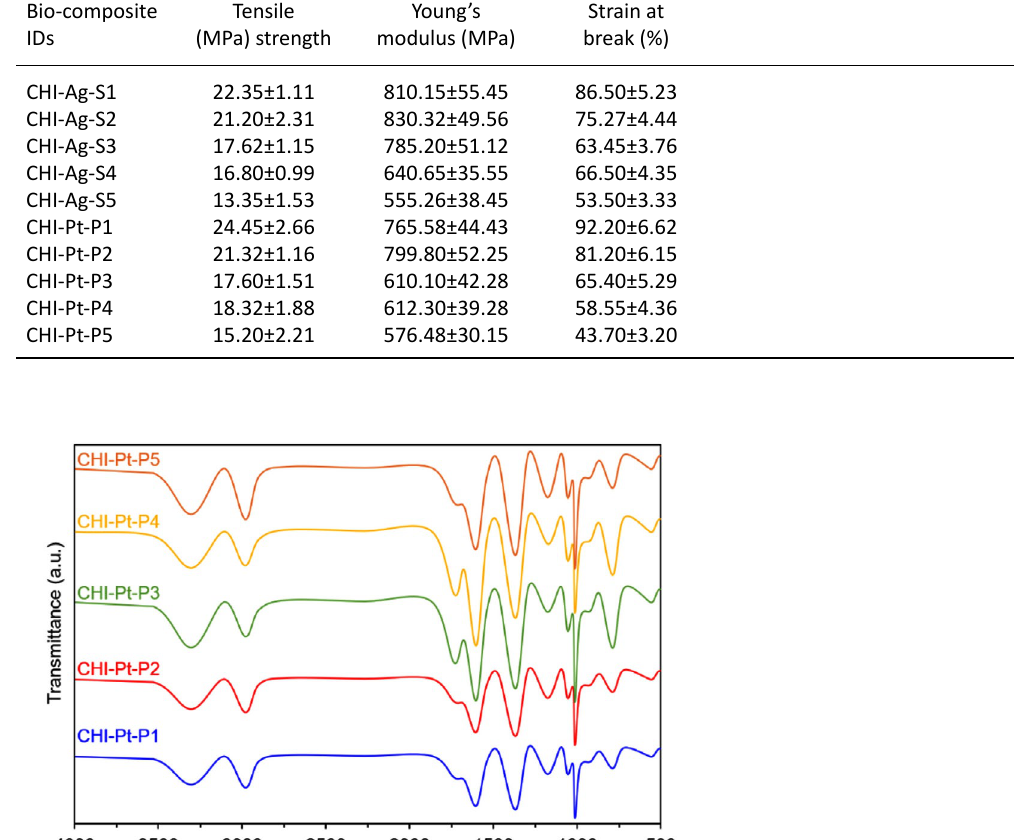
Table 4. DMA-mechanical properties of silver and platinum nanoparticles loaded chitosan-based bio-composites Bio-composite